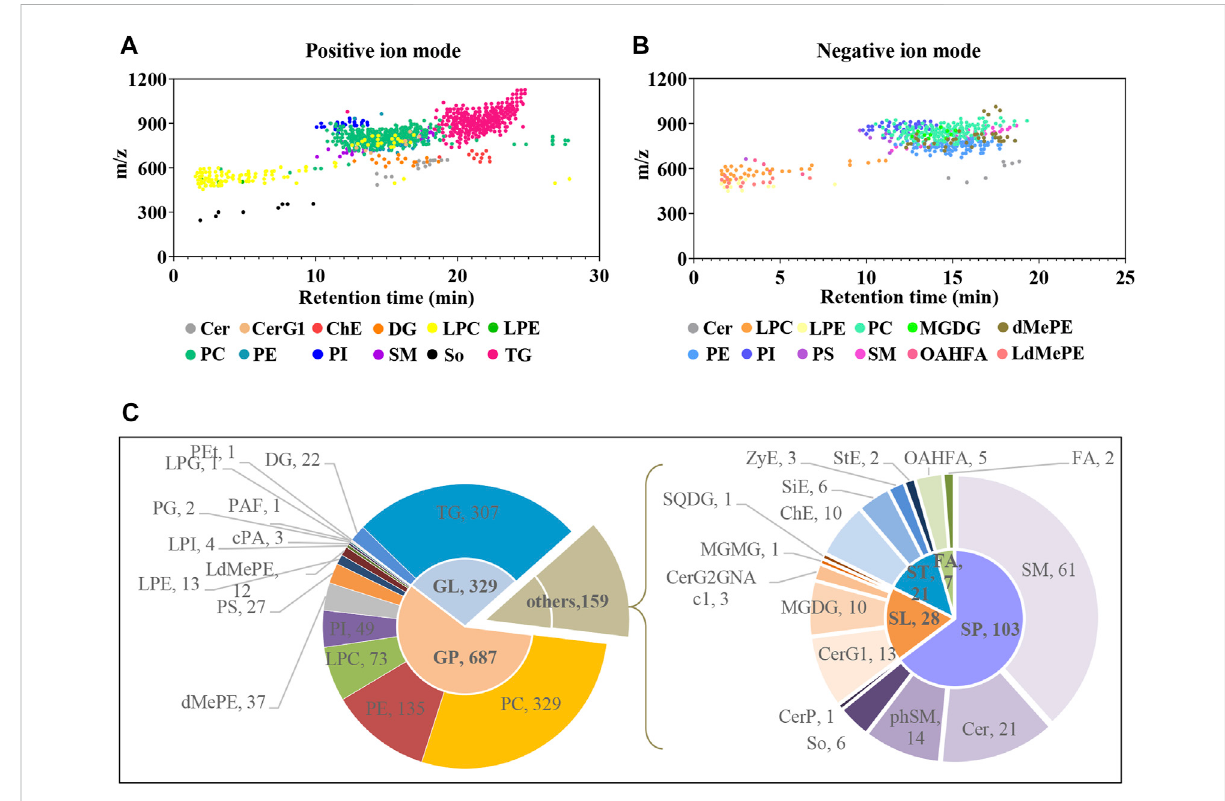
FIGURE 7 Delineation of plasma lipids detected by UHPLC-Q-Orbitrap HRMS. (A,B) Scatter plots of lipid features detected in positive and negative ion modes, respectively. (C) Pie charts showing the number of every lipid subclass belonging in each category. Cer, ceramides; CerG1, monogylcosylceramide; ChE, cholesteryl ester; DG, diglyceride; LPC, lysophosphatidylcholine; LPE, lysophosphatidylethanolamine; PC, phosphatidylcholine; PE, phosphatidylethanolamine; PI, phosphatidylinositol; SM, sphingomyelin; So, sphingoshine; TG, triglyceride; MGDG, monogalactosyldiacylglycerol; dMePE, dimethylphosphatidylethanolamine; PS, phosphatidylserine; OAHFA (O-acyl)-1-hydroxy fatty acid; LdMePE, Lysodimethylphosphatidylethanolamine; PG, phosphatidylglycerol; LPG, lysophosphatidylglycerol; PEt, phosphatidylethanol; PAF, platelet- activating factor; cPA, cyclic phosphatidic acid; SQDG, sulfoquinovosyldiacylglycerol; ZyE, zymosteryl; SiE, sitosteryl ester; MGMG, monogalactosylmonoacylglycerol; CerP, ceramides phosphate; phSM, phytosphingosine; StE, stigmasteryl ester; GP, glycerophospholipids; GL, glycerolipids; SP, sphingolipids; SL, saccharolipids; ST, sterol lipids; FA, fatty